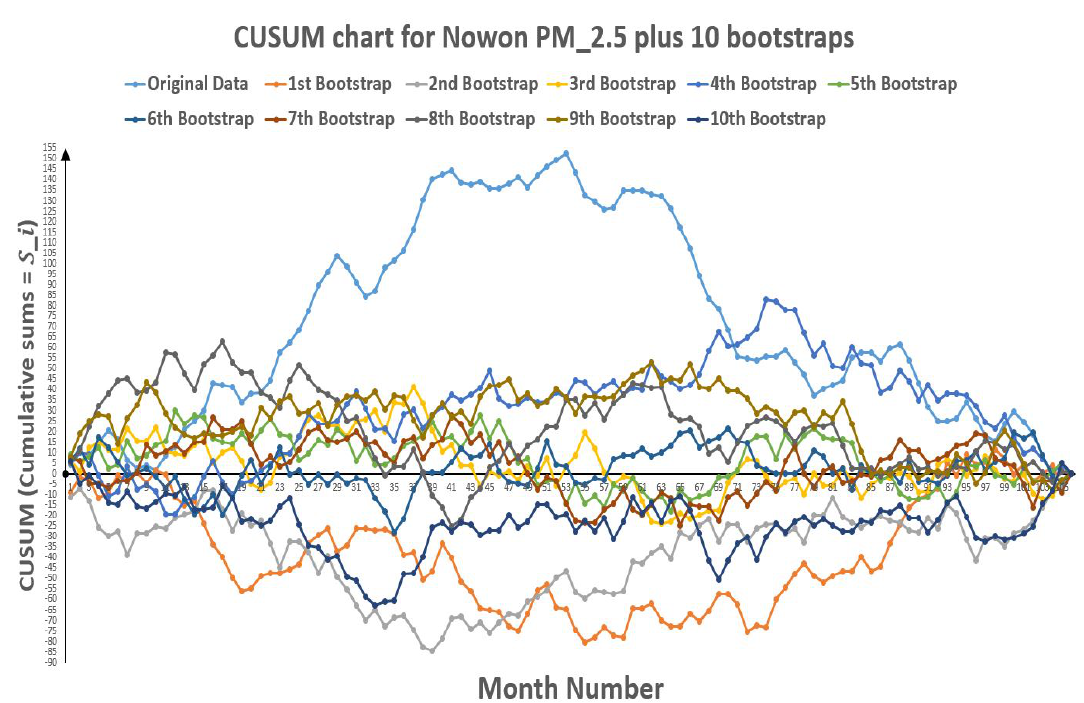
Figure 12. CUSUM chart for Nowon PM 2.5 plus 10 bootstraps (European Standards).